Question: Write a caption explaining this figure to a reader.
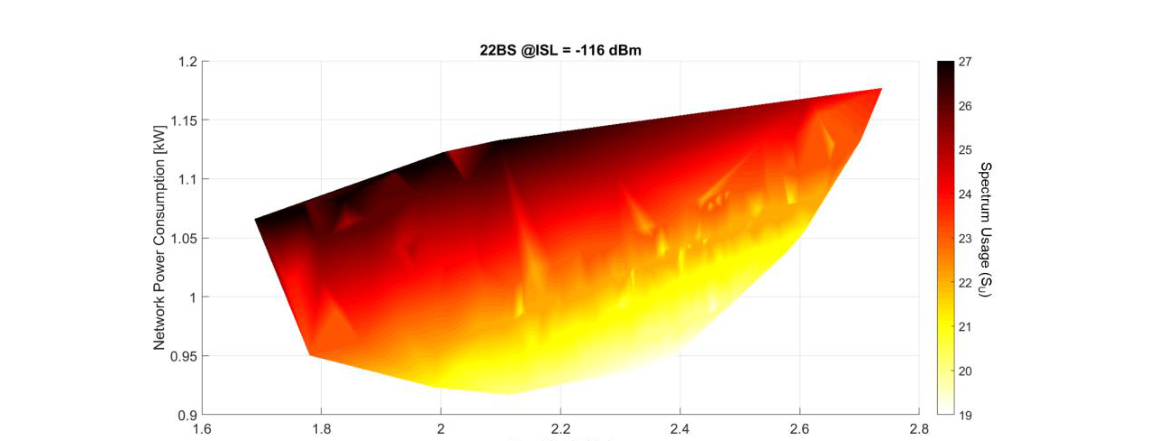
Answer: Pareto optimization results for 22 BS @ ISL = -116 dBm